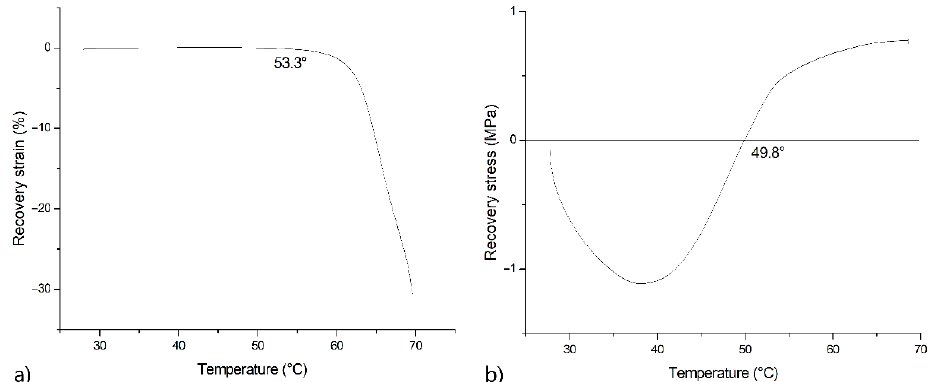
Figure 6. Recovery strain ( a ) and stress ( b ) curves for PLA + 10%PCL.